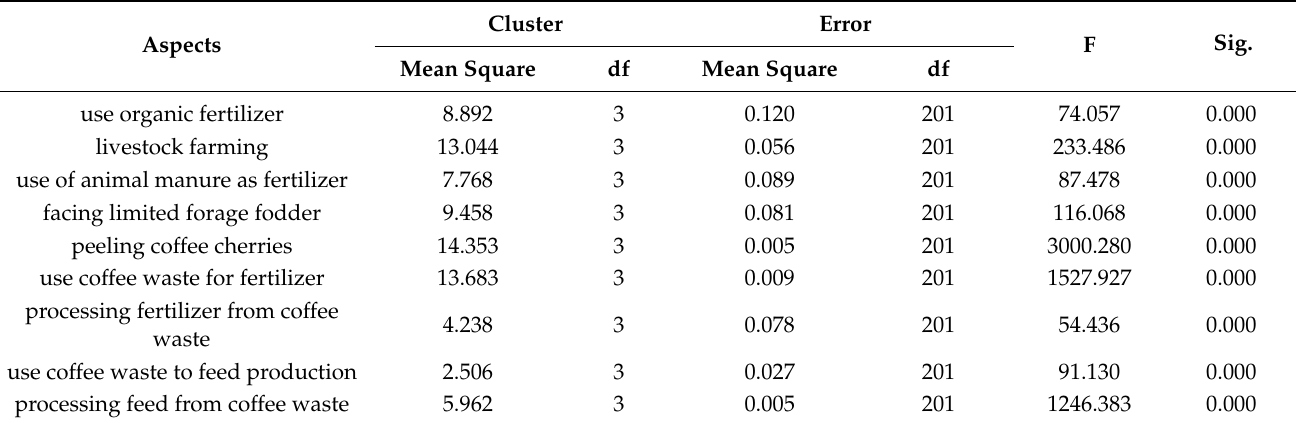
Table 10. Analysis of